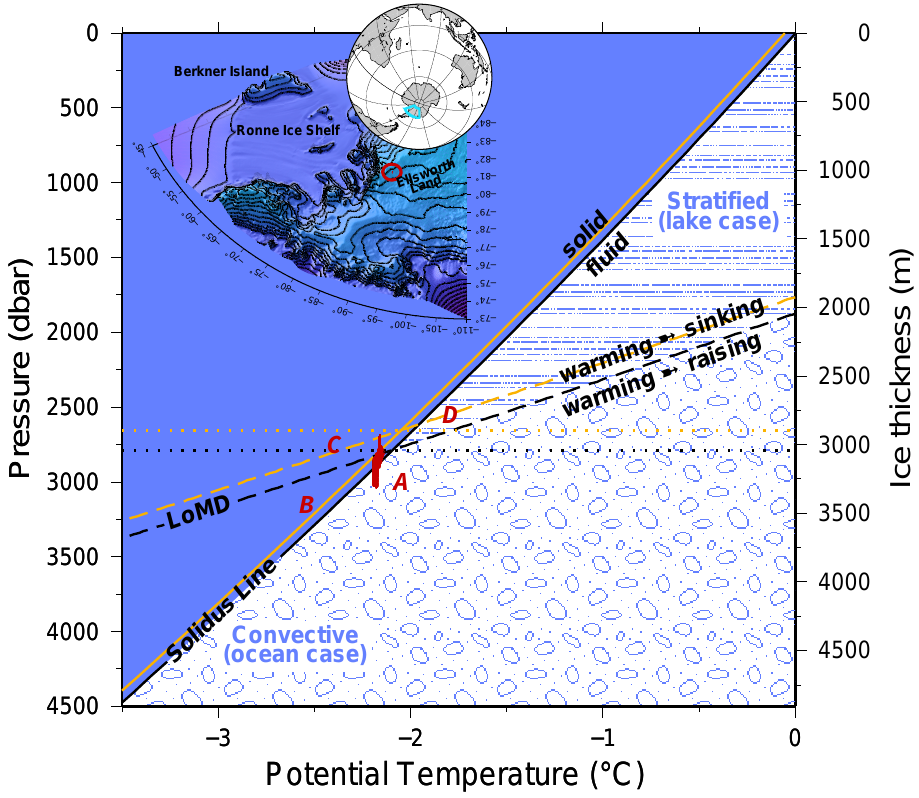
Fig. 1. Inlay: Surface topography in the area of SLE, indicated with the red circle. Contours are 200m apart. Main Figure: Solidus line (solid) and line of maximum density (L O MD, dashed) (Jackett et al., 2006) as well as the parameter space where SLE is located (red). The ice thickness refers to a density of 917kg/m 3 . The four possible temperature regimes are indicated by red letters. The dotted line indicates the critical depth (3050m) and pressure (2790dbar) where the L O MD and the solidus line intersect. Waters within regions B and C indicate fluids with supercooled conditions (hence why they appear above the solidus line). The region of the convective ocean case and the stratified lake case are separated by the L O MD. Orange lines indicate the corresponding results for a salinity of 1‰.